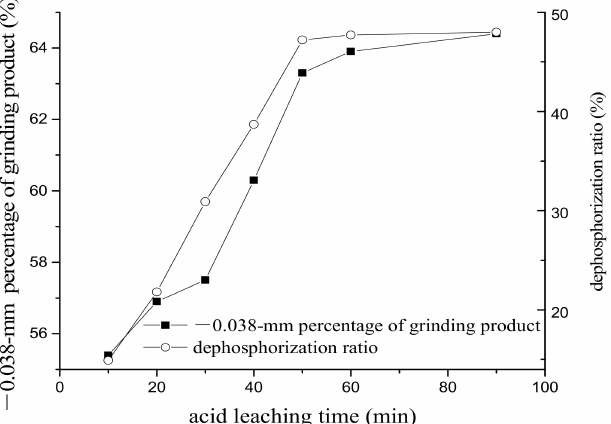
Figure 11. The − 0.038-mm percentage of the grinding product and the dephosphorization ratio at different acid leaching